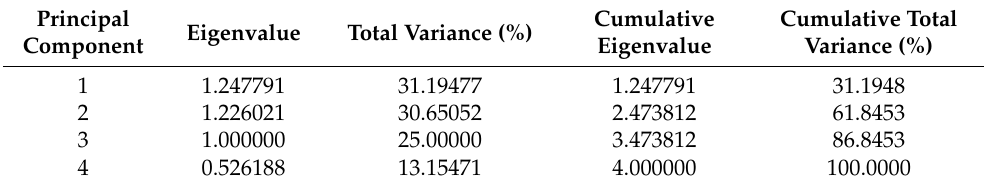
Table 3. Eigenvalues, percentage of explained variance, cumulative eigenvalues, and cumulative percentage of explained variance (%) of the principal components.